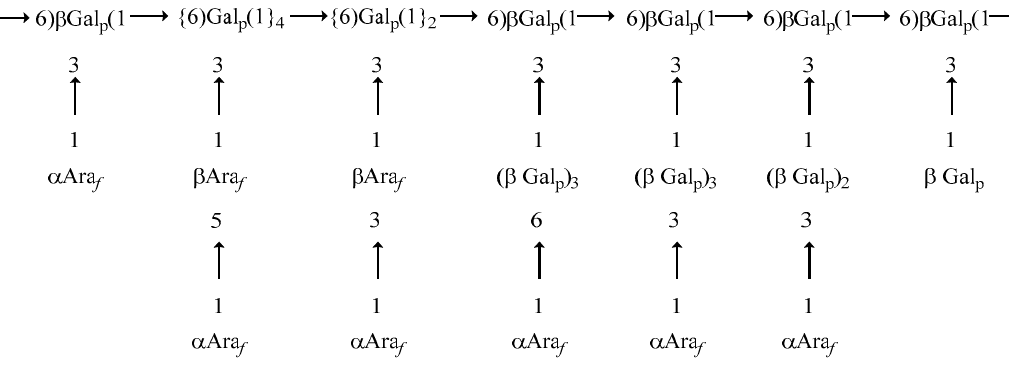
Figure 18. The complete structure of the repeat unit of the glycan of LbGp2.